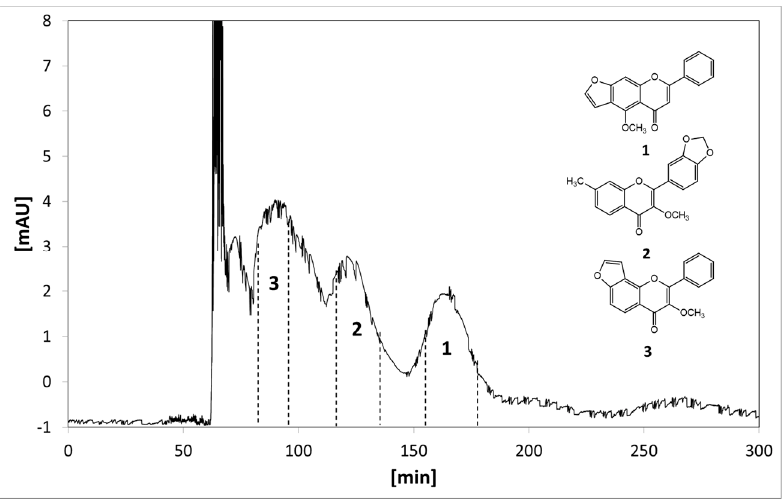
Figure 3. HSCCC chromatogram of the petroleum extract of bark of P. pinnata .